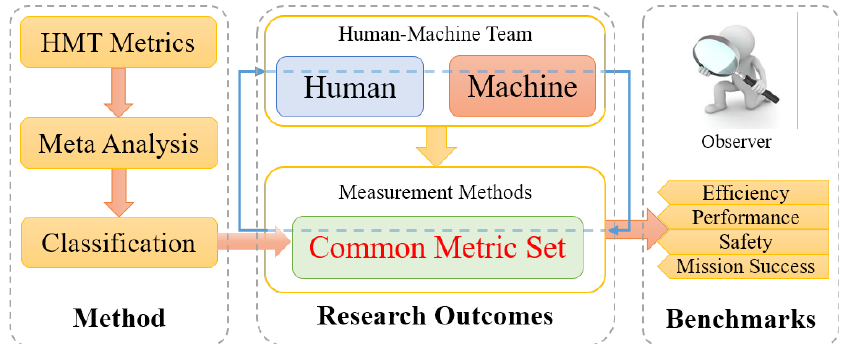
Figure 1. A graphical representation of the proposed novel human-in-loop (HIL) simulation for human–machine teaming (HMT) standardization (reproduced from